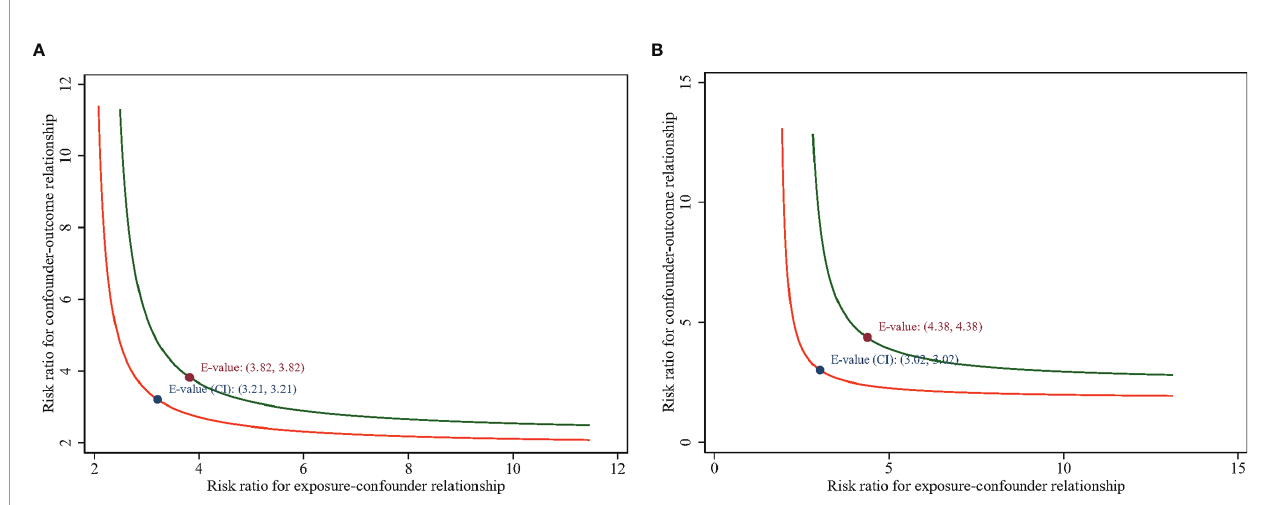
FIGURE 3 | E-value for the lower 95% CI and point estimate in (A) all-cause mortality and (B) cardiovascular